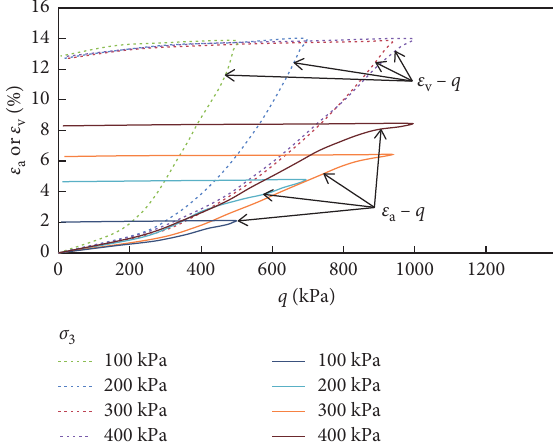
Figure 3: Comparison between e in and e . Figure 4: Stress-strain curves of intact loess specimens during anisotropic loading-unloading